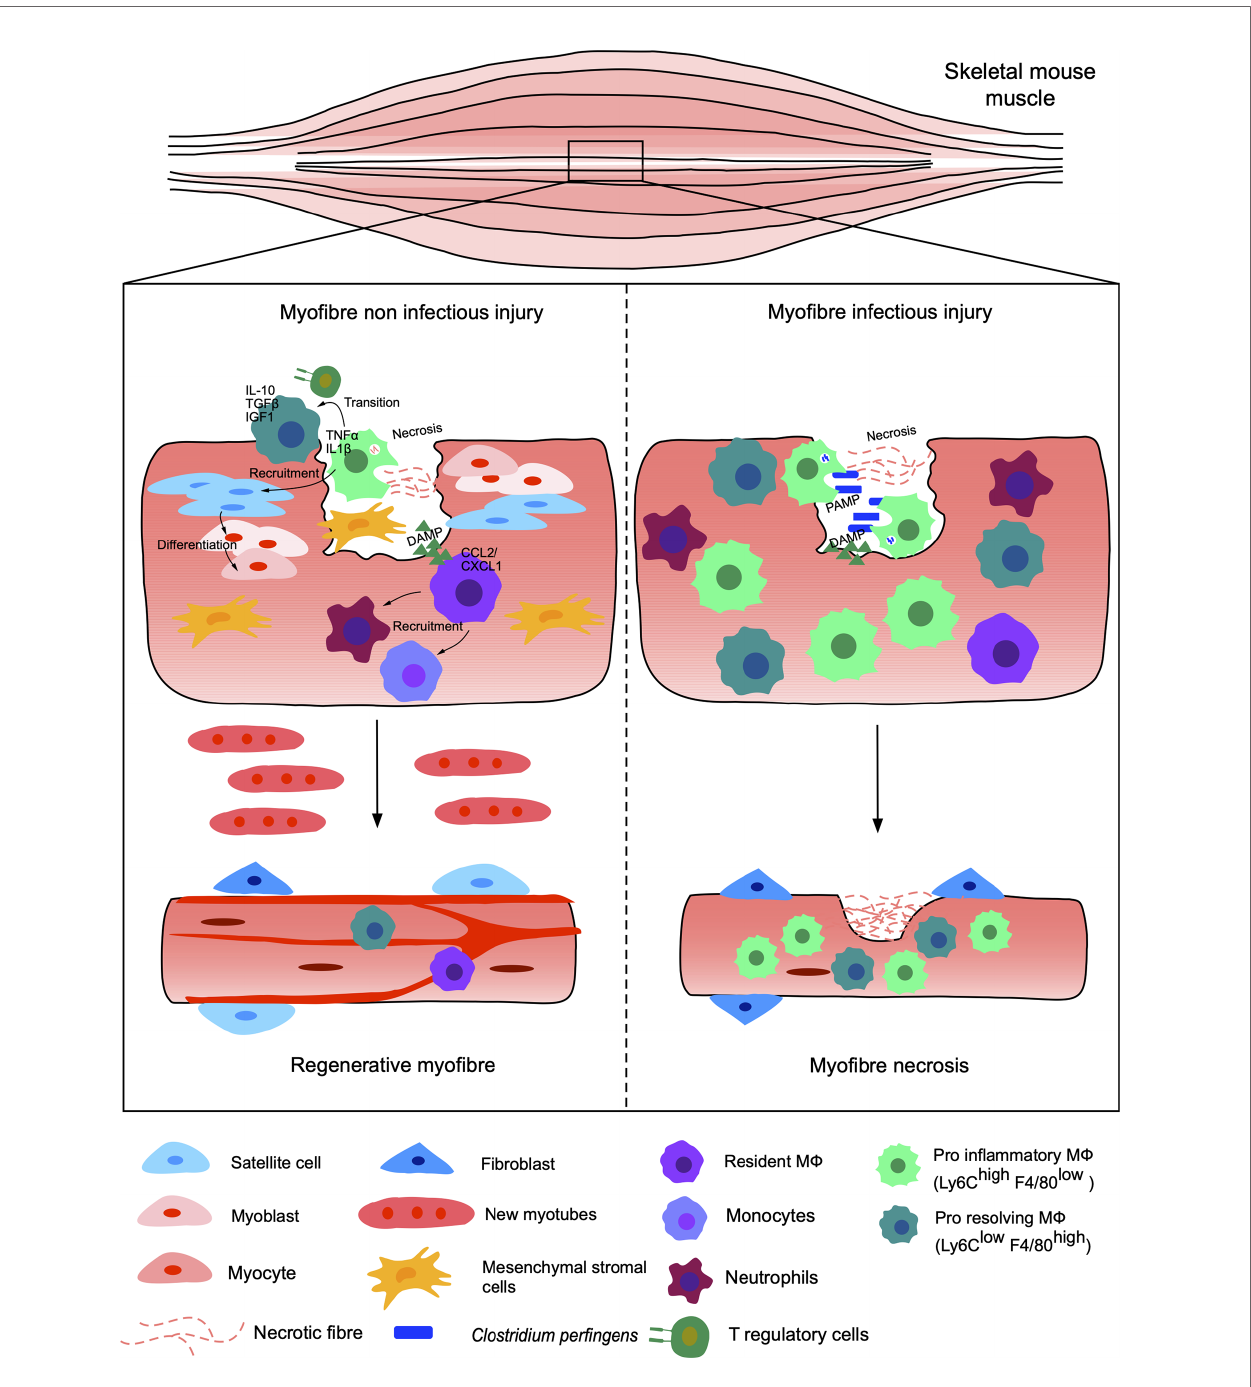
FIGURE 1 | Non-infected versus infected injuries of the murine skeletal muscle. Injury of muscle myo fi bers under sterile conditions, such as freezing, chemical injections or exposure to toxins, leads to necrosis of the myo fi bers and endothelial cells responsible for the release of DAMPs. Resident M Ф respond to DAMPs and recruit neutrophils and other monocyte-derived M Ф by releasing CCL2/CXCL1. The pro-in fl ammatory Ly6Chi F4/80 low M Ф , TNF a and IL-1 b positive, eliminate dead cells and recruit satellite stem cells as well as myogenic precursors secreting pro-in fl ammatory cytokines. The pro-in fl ammatory M Ф are then gradually replaced by anti-in fl ammatory M Ф , known as pro-resolving Ly6Clow F4/80 high secreting IGF1, IL10 and TGF b . The switch of M Ф subpopulations is induced in part by the phagocytosis of debris by pro-in fl ammatory M Ф , which activate the AMPK and C/EBPb pathways, but also via the presence of T regulatory cells. Finally, stromal mesenchymal cells (FAP) are recruited and support myogenesis. The satellite cells generate myoblasts, differentiating into myocytes giving new myo fi bers and functional regenerated tissue. This same injury under infectious conditions, for example in the presence of Clostridium perfringens , leads to a signi fi cant recruitment of pro-in fl ammatory M Ф . The pro- and anti-in fl ammatory balance is dysregulated and the in fl ammation becomes excessive and persistent. Thus, the tissue does not regenerate and becomes necrotic, losing its functional